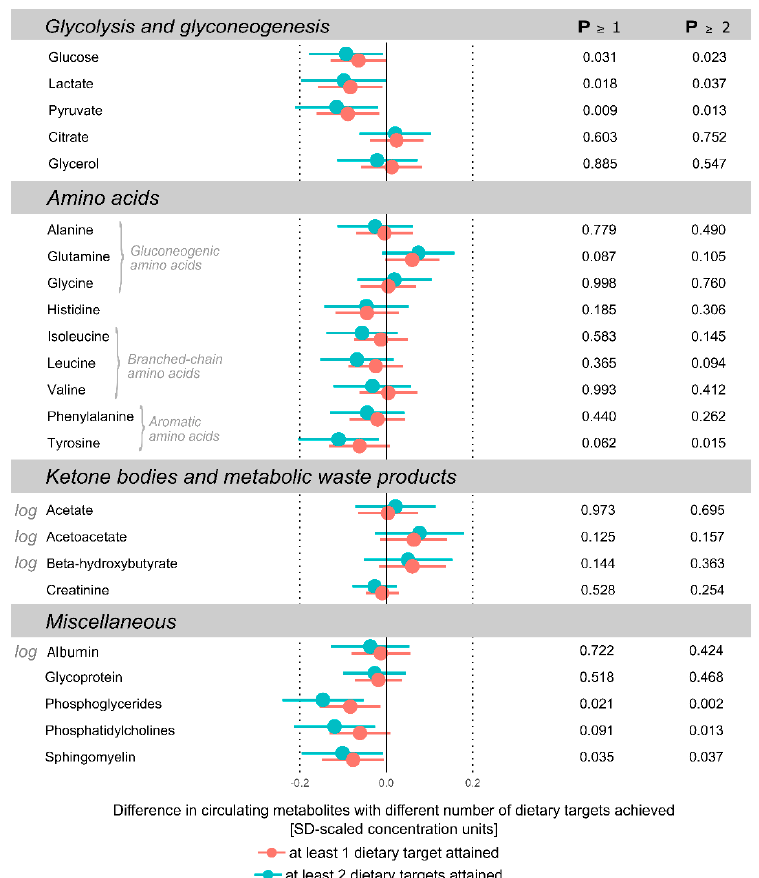
Figure 3. Differences in circulating metabolites between achieving the dietary targets compared to achieving none of the dietary targets. Effect estimates are standard deviation scaled differences between achieving zero dietary targets with respect to achieving ≥ 1 (red) or ≥ 2 (blue) of the targets. Error bars indicate 95% confidence intervals. Metabolic measures are from pooled analyses across the six time points, and those with skewed distributions were log(x + 1)-transformed prior to the analyses.